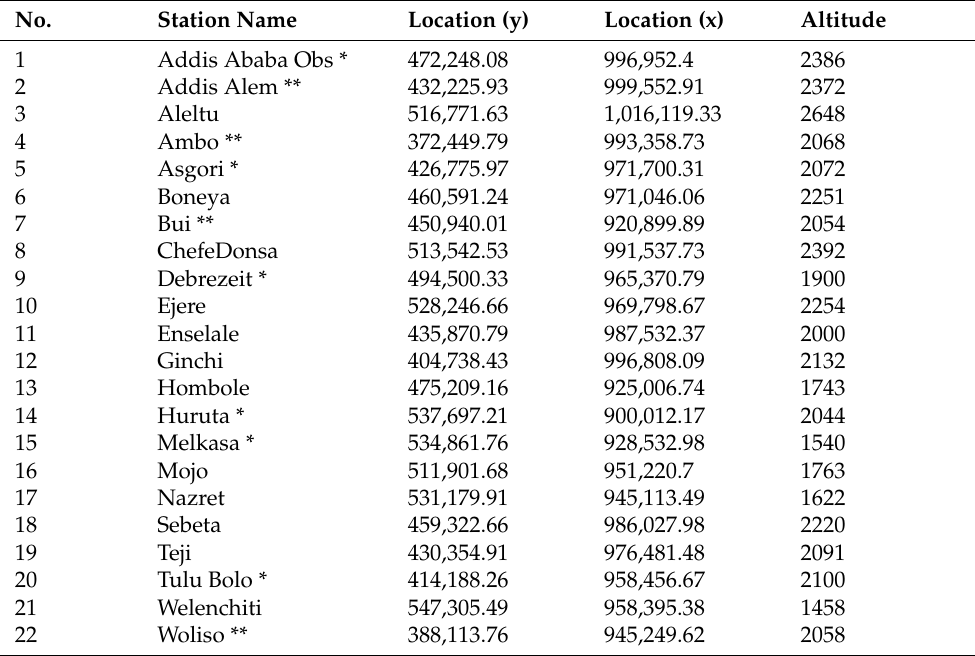
Figure 1. Map of the upper Awash sub-basin with major rivers and locations of metrological stations. Table 1. List of names of meteorological stations in the upper Awash sub-basin with their locations (UTM (Universal Transverse Mercator)) and altitude (m) were used for the